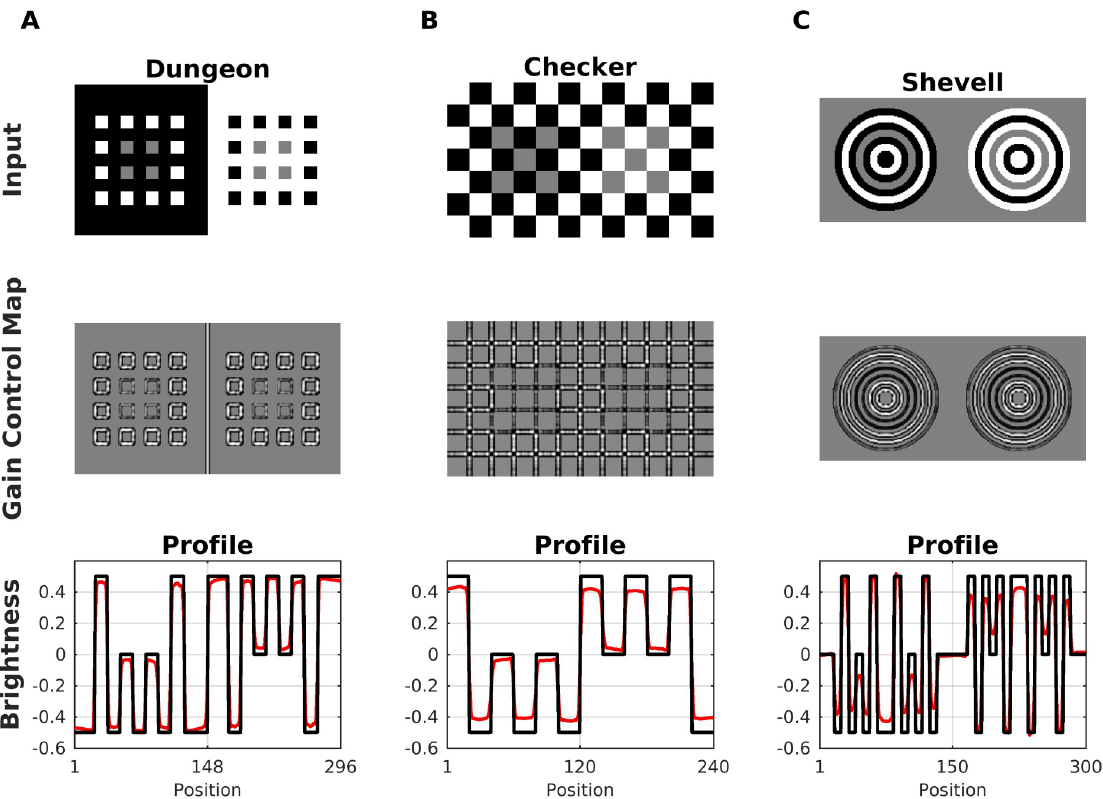
Fig 16. Model predictions for Dungeon, Checkerboard and Shevell. In each display, the gray areas have the same luminance, yet they are perceived differently because of assimilation with the adjacent structures. (A) Top: Dungeon illusion. Middle, corresponding gain control map. Bottom, profile plot of the estimated brightness (red line) compared with the input (black line). (B) Checkerboard illusion. (C) Shevell’s Rings. Notice that this illusion cannot be explained with